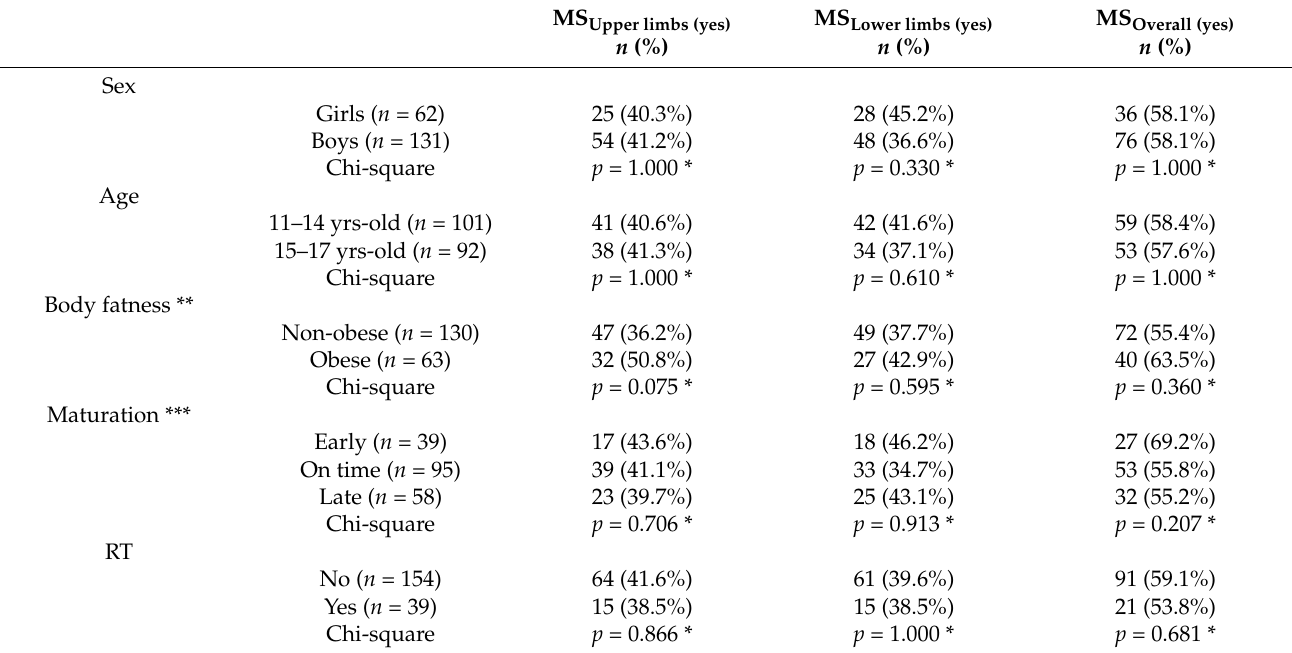
Table 2. Association between musculoskeletal symptoms and independent variables among adoles- cents (ABCD—Growth Study; n =